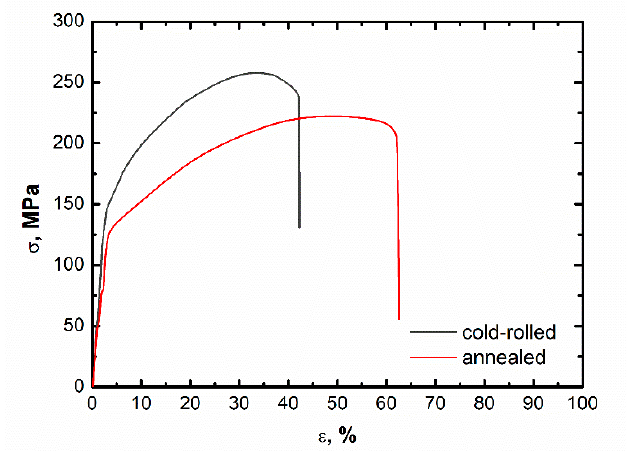
Figure 10. Stress-strain curves of annealed and H58 DHP Figure 10. Stress ‐ strain curves of annealed and H58 DHP Cu.